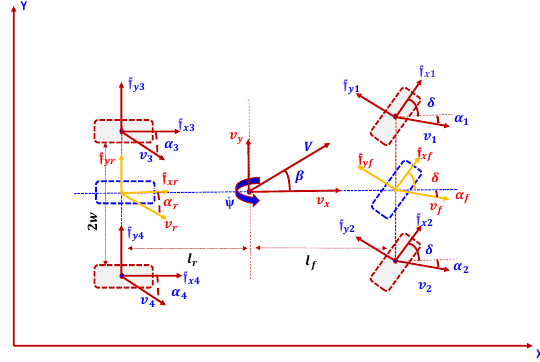
Figure 3. Four-wheel vehicle model and bicycle model.